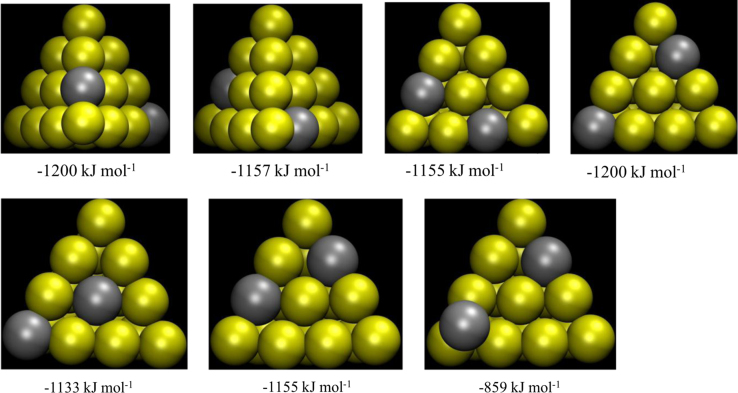
Representative stable structures of Au18Ag2 and corresponding formation energies.